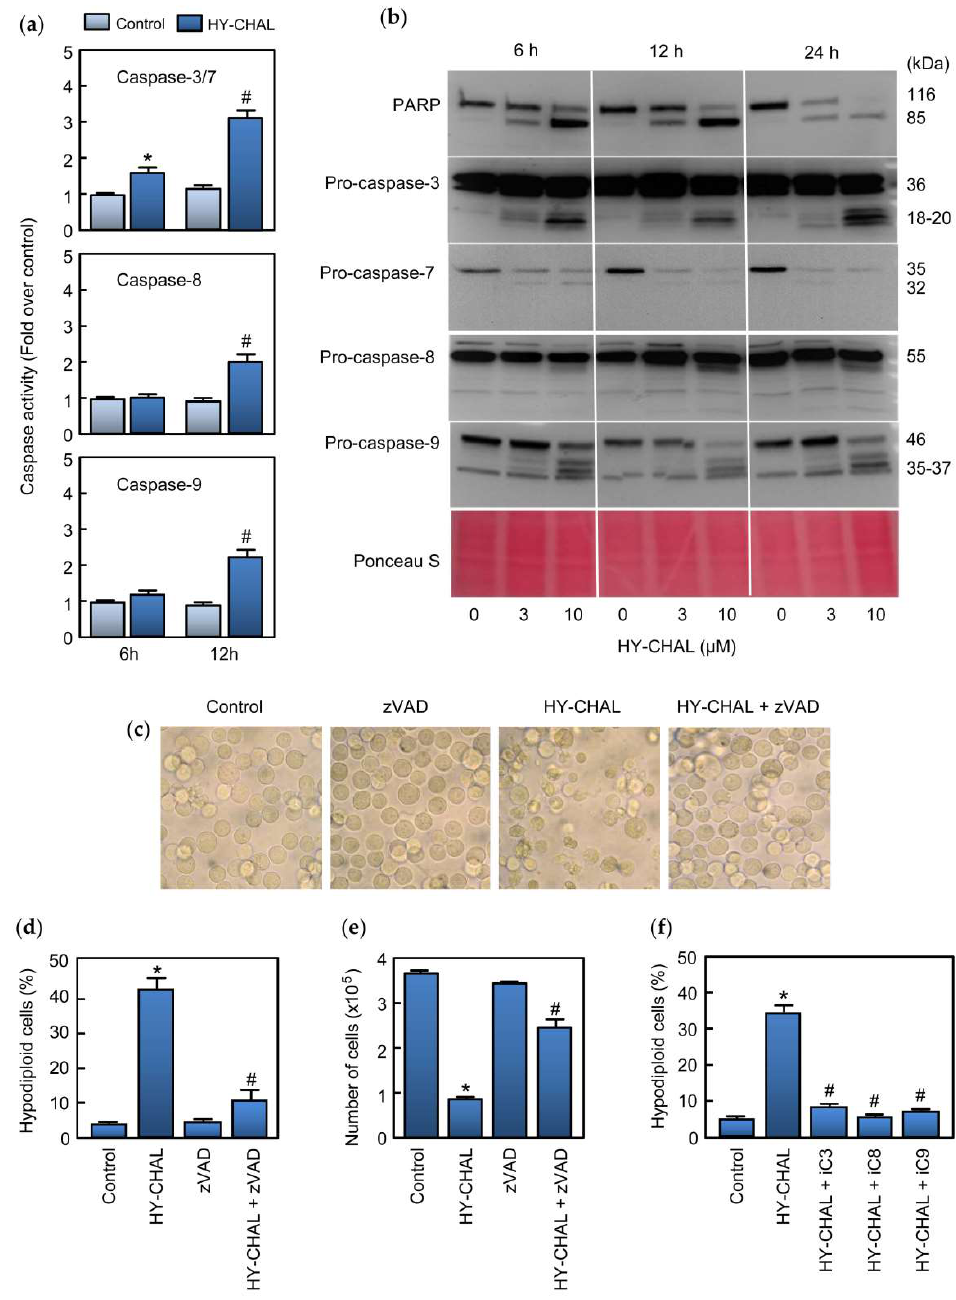
Figure 3. HY-CHAL induced caspase cascade in SK-MEL-1 melanoma cells. ( a ) Cells were treated with 3 µ M HY-CHAL for the indicated times and caspase activation was determined using specific colorimetric substrates; ( b ) Cells were treated with the specified concentrations of HY-CHAL and poly(ADP-ribose) polymerase (PARP) cleavage and caspase processing was determined by immunoblotting. The membrane was stained with Ponceau S before antibody detection to control equal protein loading; ( c ) Cells were pretreated with 100 µM z-VAD-fmk for 1 h and then incubated in the absence or in the presence of 3 µM HY-CHAL for 24 h and images were obtained with an inverted phase-contrast microscope; ( d ) Cells were treated as in ( c ) and hypodiploid cells (i.e., apoptotic cells) were analyzed by flow cytometry. Bars represent the mean ± SE of three independent experiments each performed in triplicate. * Indicates p < 0.05 for comparison with untreated control. # Indicates p < 0.05 for comparison with HY-CHAL treatment alone; ( e ) Cells were treated as in ( c ) and cell viability was determined by the trypan blue exclusion method using a TC counter; ( f ) Cells were pretreated with the selective caspase inhibitors z-DEVD-fmk (iC3, 50 µ M), z-IETD-fmk (iC8, 50 µ M) and z-LEHD-fmk (iC9, 50 µ M) for 1 h before the addition of 3 µ M HY-CHAL and apoptotic cells were quantified as in ( d